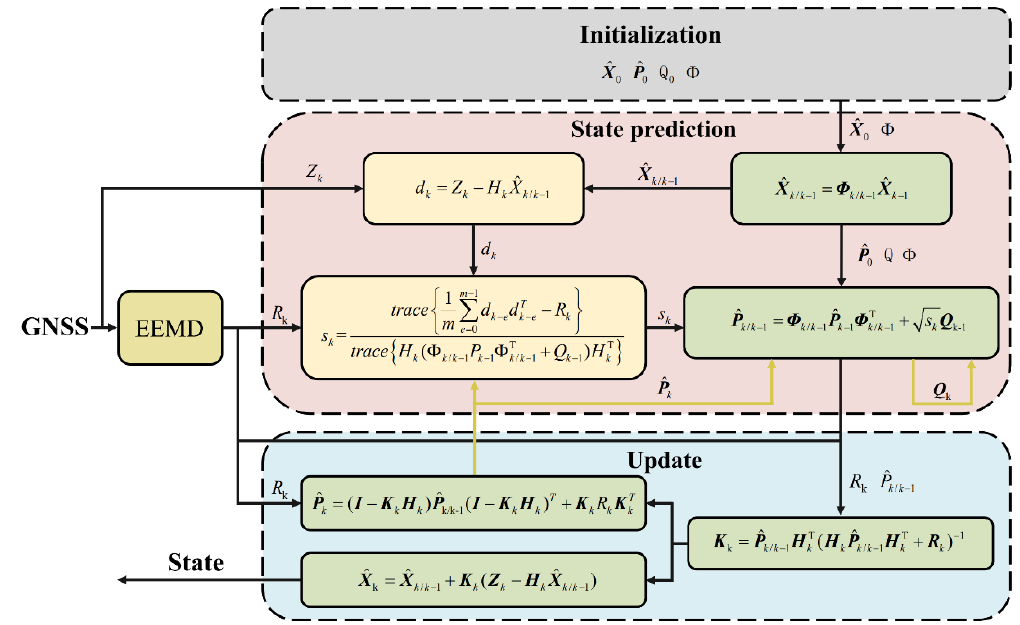
Figure 1. Process of Dynamic Adaptive Kalman Filter.